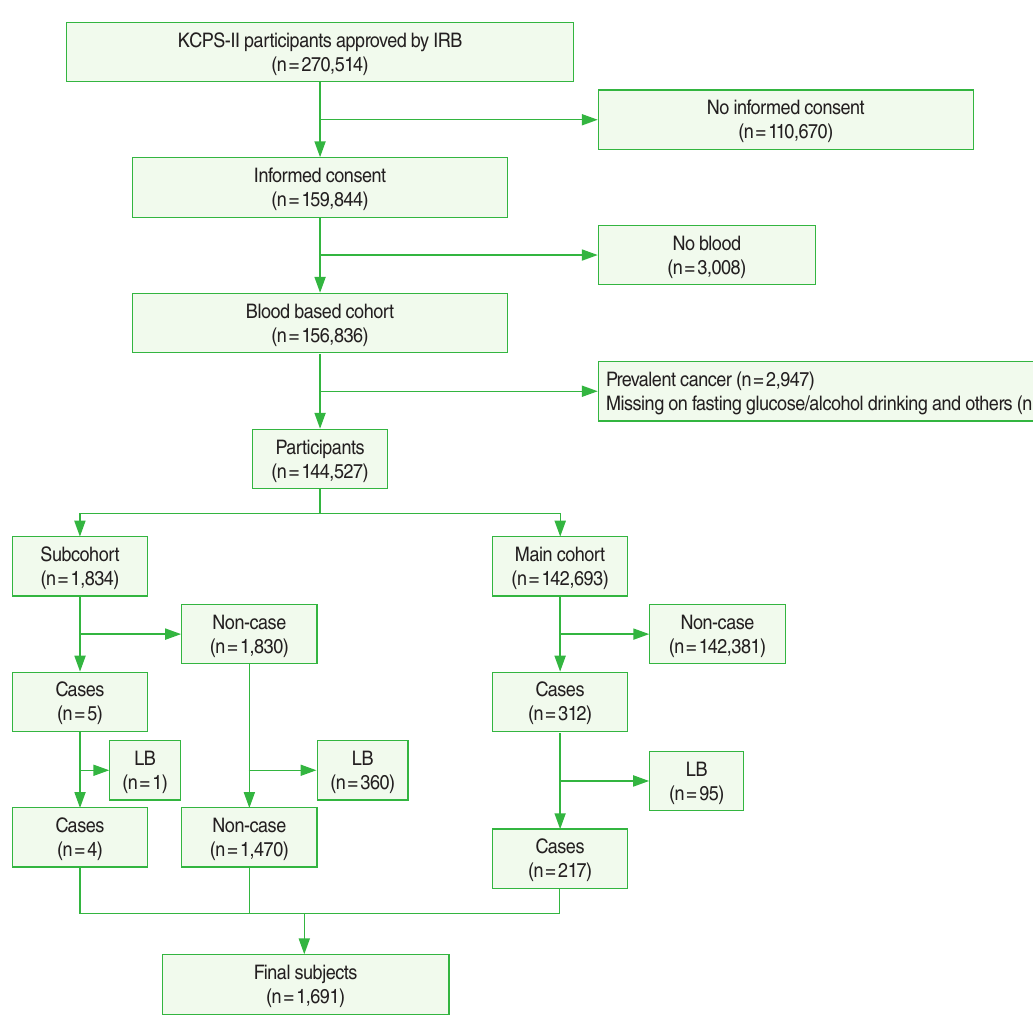
Figure 1. Flow chart describing sample size. KCPS-II. Korean Cancer Prevention Study-II; IRB, institutional review board; LB, limited amount of